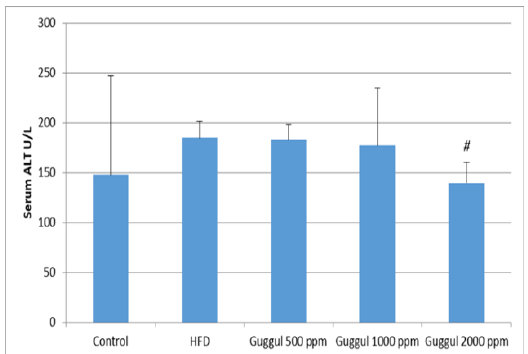
Figure (6) Effects of guggulsterone on serum ALT level of mice models with high-fat diet induced NAFLD.